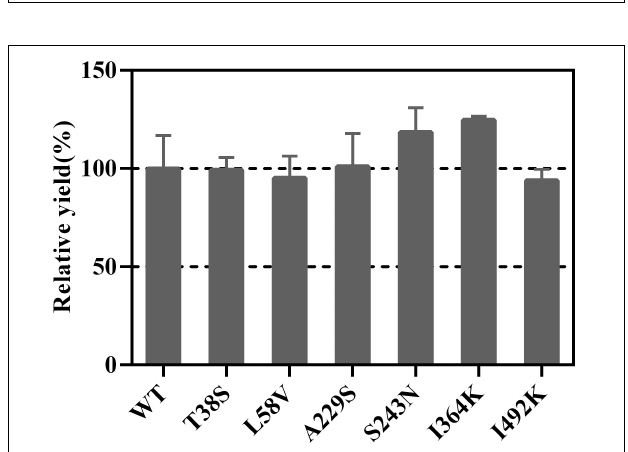
FIGURE 5 | The relative yields of selected mutants compared with